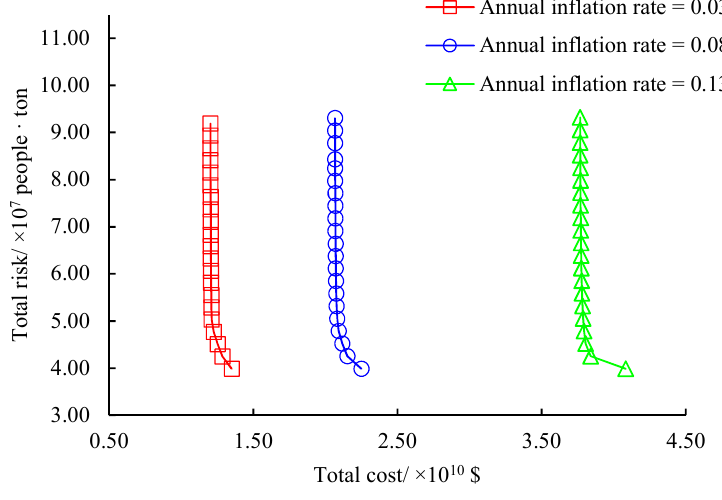
Figure 9. Effects of annual inflation